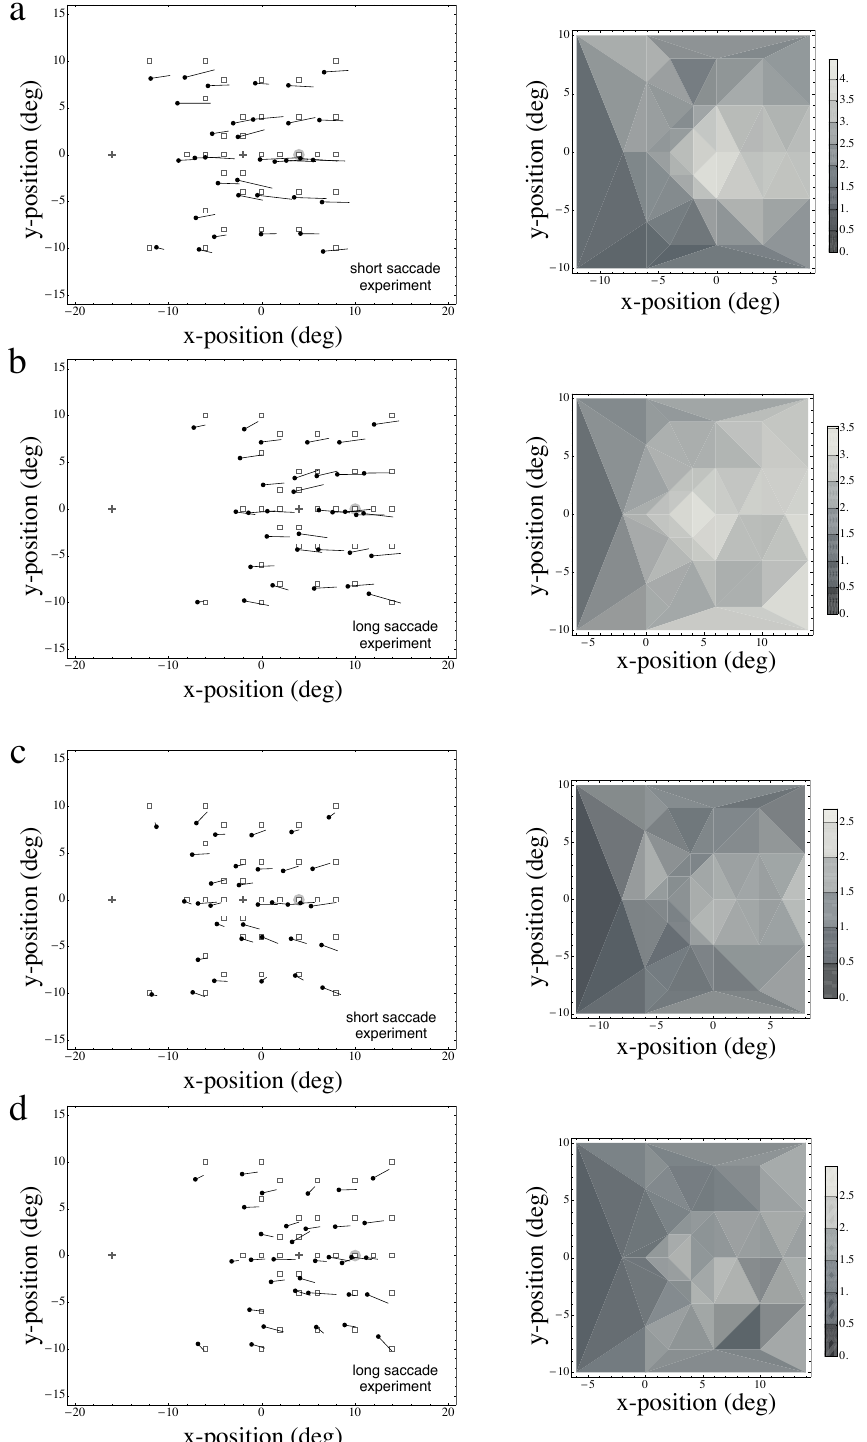
Figure 9 . Localization judgements. Target on localization condition in the short saccade experiment (a) and long saccade experiment (b). Target off localization condition in the short saccade experiment (c) and long saccade experiment (d). Filled circles indicate localization judgements in the pre-adaptation phase while the line ends indicate the corresponding judgements in the post-adaptation phase. All figures are with their corresponding heat